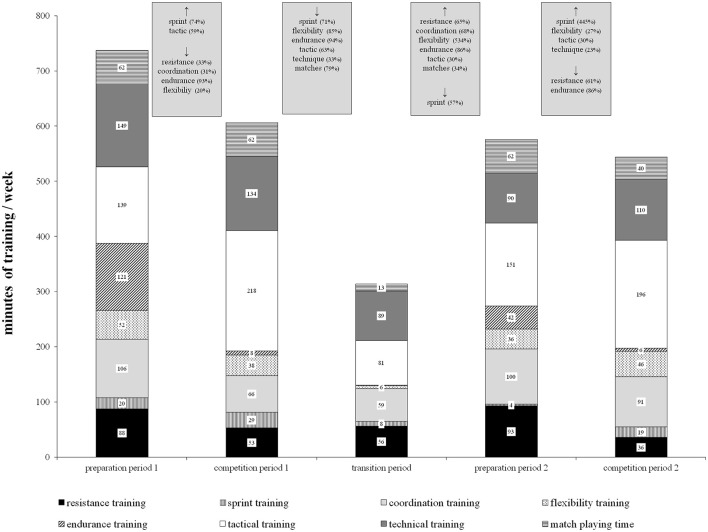
Training volumes classified by training types for each training period in female elite young soccer players. Note that gray boxes denote significant changes. Data are reported as means for the female young soccer team.